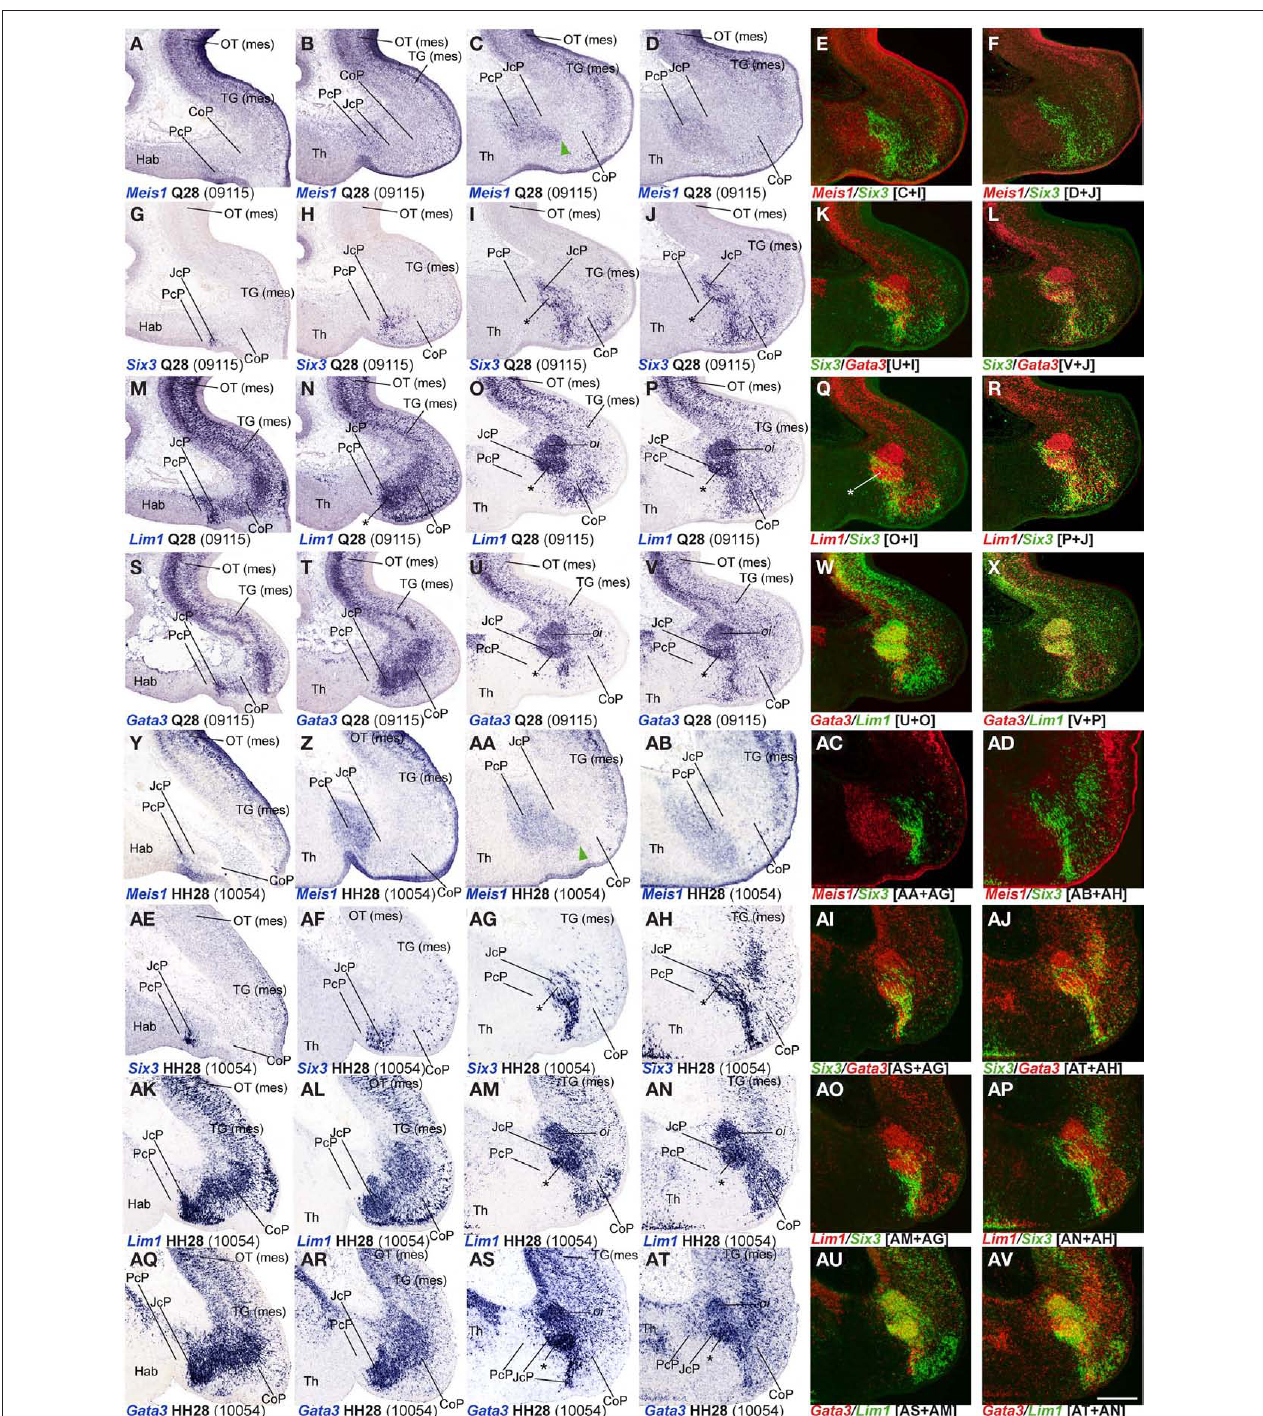
markers in the quail, and the last four rows contain comparable material for the chick, so that panels taken long the vertical columns represent essentially the same section level and are comparable across the species. Green arrowheads in (C,AA) mark cells expressing a PcP marker that are found inside the differentially specified JcP domain. Asterisks in (I,J,O,P,u,V,AG,AH,AM,AN,AS,AT) identify the developing lateral spiriform nucleus. Numbers between brackets: code of the specimen in our collection. Scale bar =